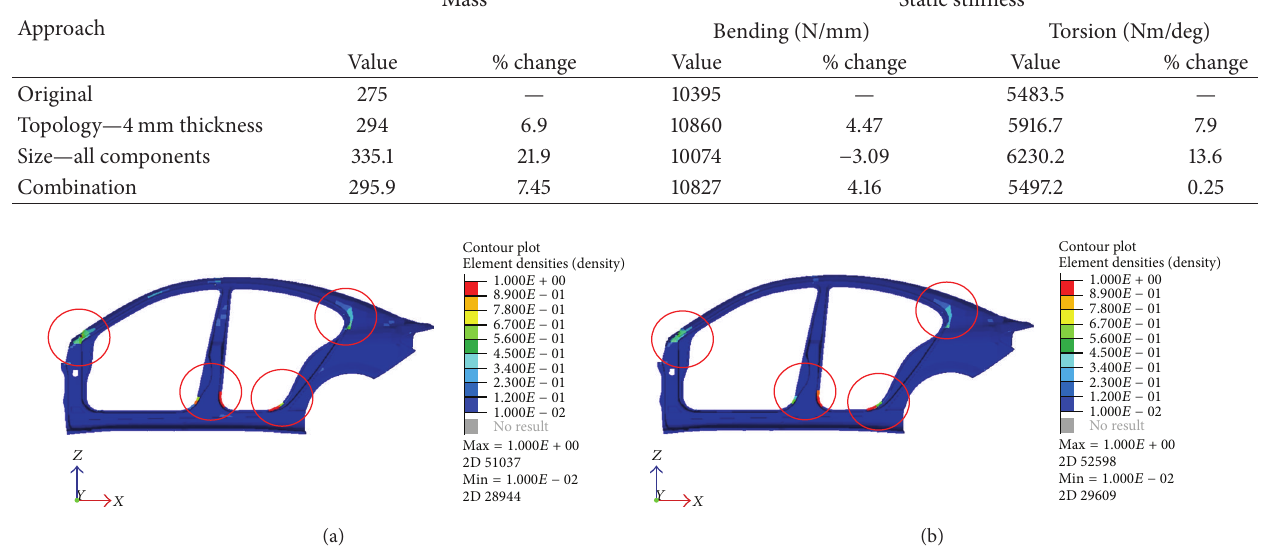
Figure 10: Highlight of reinforcement areas on outer quarter panel for 4 mm and 3.2